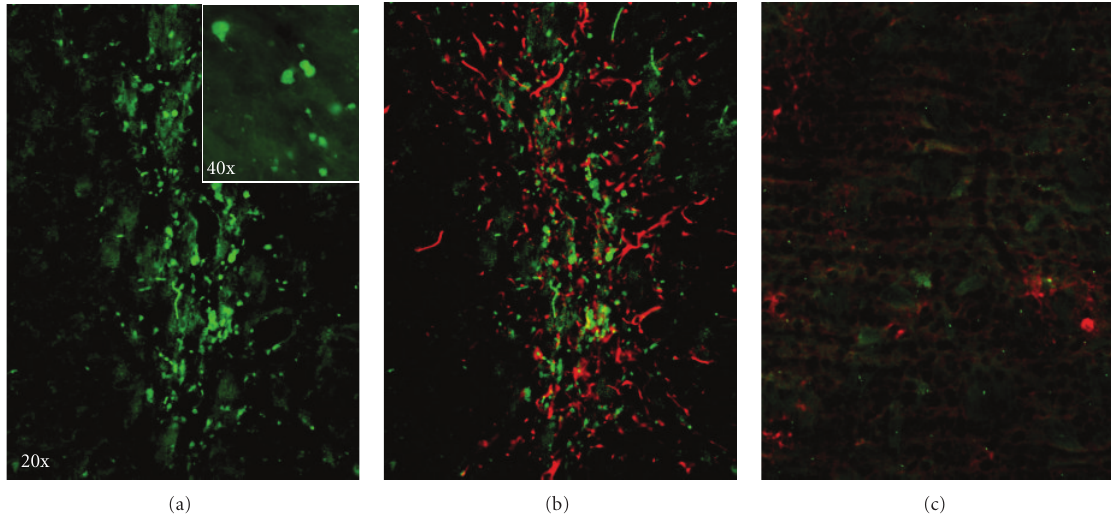
Figure 4: Double label immunohistochemistry shows close association between glial fibrillary acidic protein (GFAP) and autofluorescence along the injector needle track in the striatum, 2 months after intranasal delivery of MSC-EGFPs. (a) Green autofluorescence along needle track. Inset, higher-magnification image from (a). (b) GFAP (red) expression is strong along the needle track. (c) Substantially less GFAP, and no green autofluorescence, is detected in the contralateral striatal